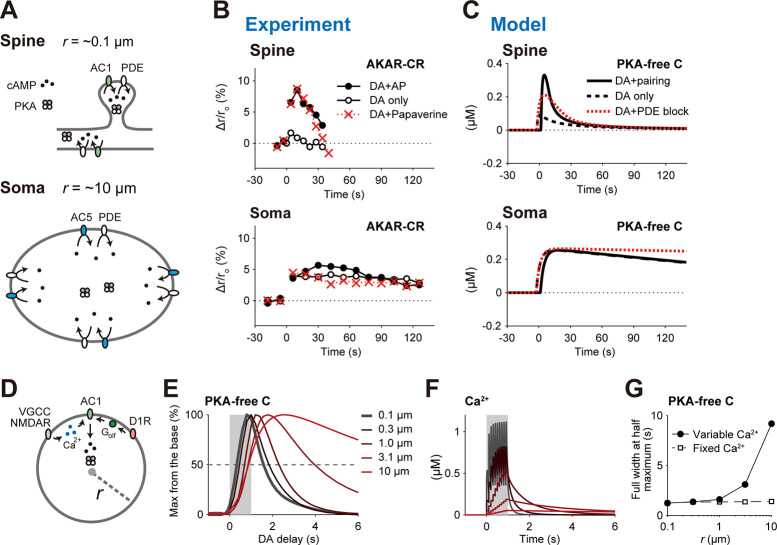
Smallness of spines was important for short-term PKA activity and its time window.(A) Domain size affects cAMP dynamics. Spines/thin dendrites are small (radius r = ~0.1 μm), thus having small cytosolic volumes per membrane area (top). The membrane AC1 activity rapidly increases cytosolic cAMP level (the number density of black points), which is rapidly decreased by the membrane PDE. In the somas, cAMP level is increased by the membrane AC5, and slowly decreased by the membrane PDE (bottom). The cAMP levels (the number density of black points per cytosolic volume) are detected by PKA. (B) PKA activities (AKAR2-CR) in the spines and somas in the experiment [4]. Here, DA denotes DA burst, AP designates postsynaptic burst, and papaverine is a PDE inhibitor. The data were taken from the experiment by Yagishita et al. [4]. (C) The simulated PKA activity dynamics with (red dotted lines) and without (black lines) an 80% decrease in PDE. (D–G) Small domain size is necessary for the short time window for PKA activity. (D) A spherical domain with the radius (r). In this domain, pre–post pairing activated VGCCs and NMDARs, increasing cytosolic Ca2+ level for AC1 activation, while DA burst activated AC1 via membrane Golf. (E) Time windows for the PKA activity in the domain with the indicated radiuses r. (F) Ca2+ dynamics with the radiuses r indicated in (E). (G) Radius dependence of FWHMs of the time windows. The FWHMs under a fixed Ca2+ dynamics (same in the case of r = 0.1 μm) were also plotted (dashed line).